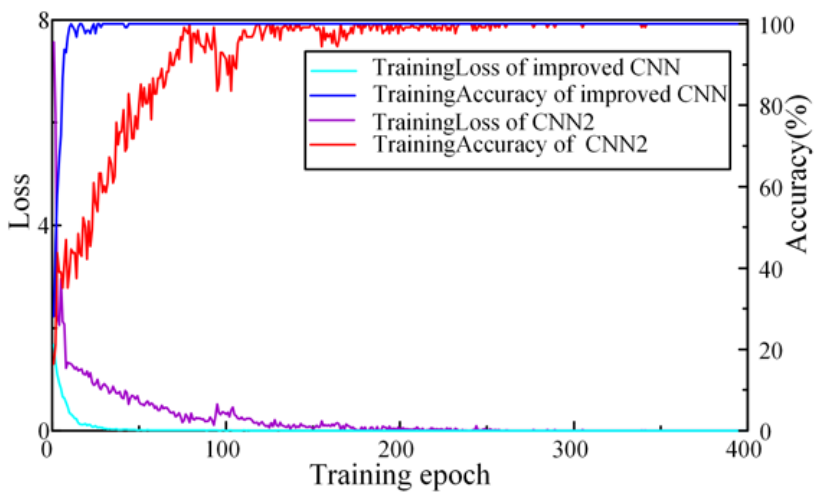
Figure 13. Two model training iteration curves.